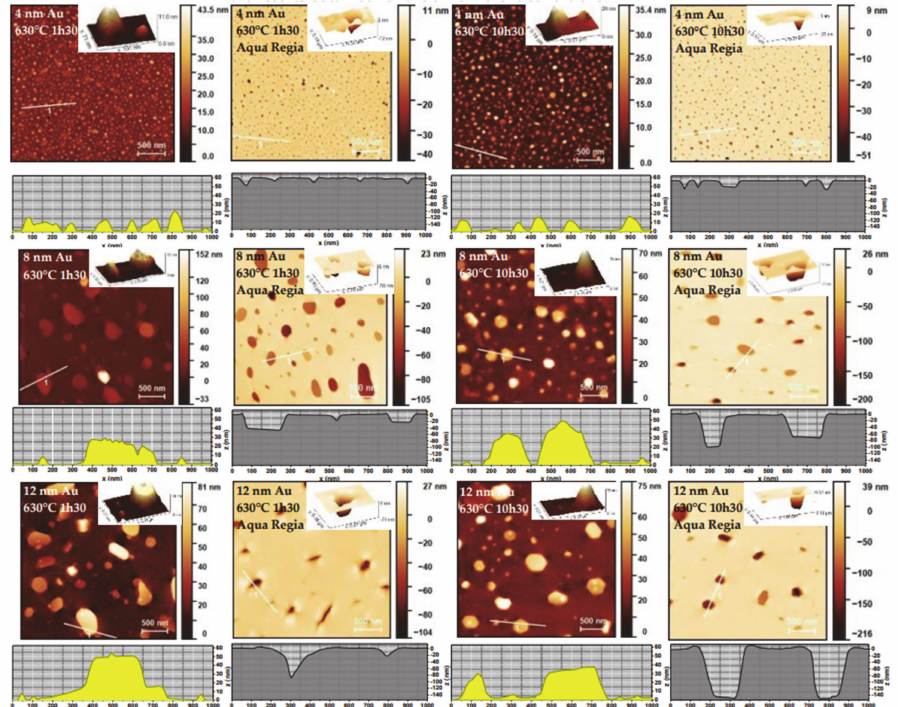
Figure 2. AFM pictures of each thermally annealed sample (at 630 ◦ C, for 1 h 30 and 10 h 30), before and after Au dissolution with aqua regia solution. Insets show close-up images in 3D. Selected line profiles are depicted below each AFM